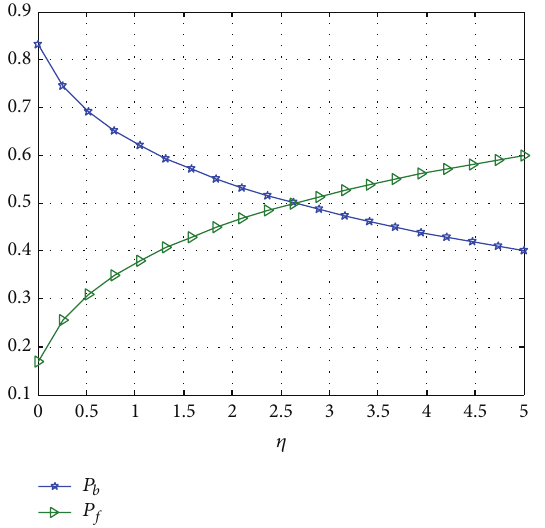
Figure 7: The probability of server’s state with the change of 𝛼